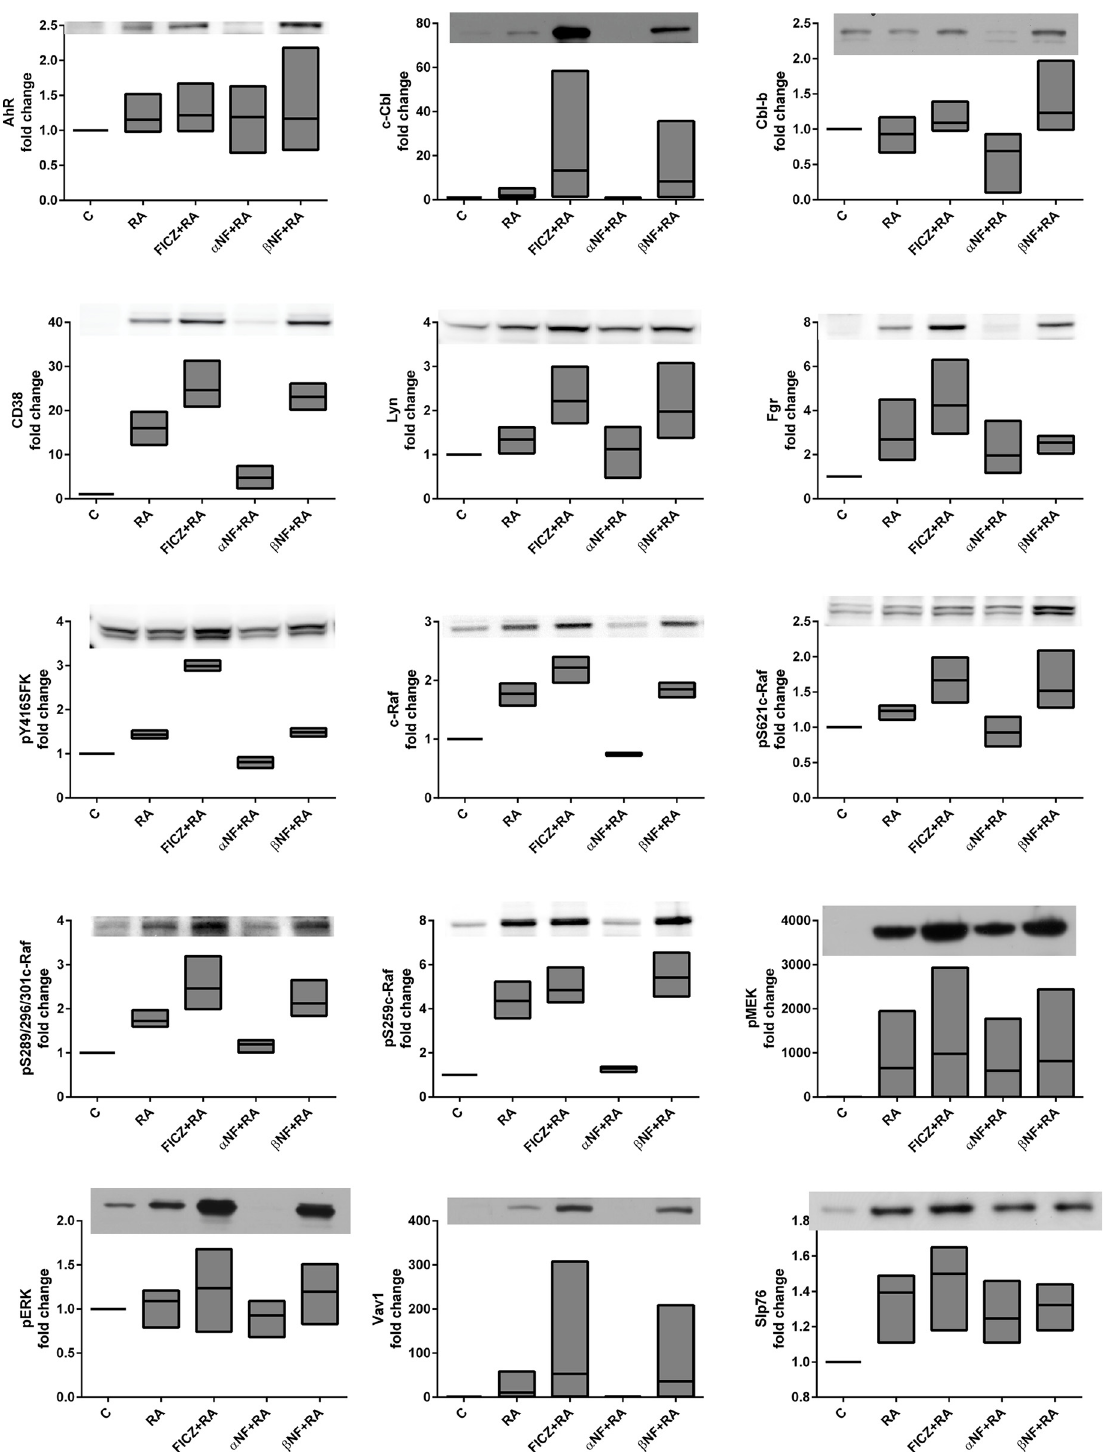
Fig 5. FICZ modulates RA-elicited signalsome. HL-60 cells were initiated in culture at 0.1 x 10 6 cells/ml with 1 μ M RA, 100 nM FICZ, 1 μ M α -NF and 1 μ M β -NF as indicated. Western blot assay of whole cell lysates is shown for AhR, c-Cbl, Cbl-b, CD38, Lyn, Fgr, pY416SFK, c-Raf, pS621c-Raf, pS289/296/301c- Raf, pS259c-Raf, pMEK, pERK, Vav1, Slp76. Whole cell lysates were collected after 48 h. Lysates were resolved on a 12% polyacrylamide gel. 25 μ g of protein was loaded in each well. Experiments were repeated at least three times. All the western blot data were quantified using ImageJ, normalized to GAPDH and then to untreated control and graphed as min to max floating bars with a line at the mean using GraphPad Prism software. P-value analysis cannot be performed on quantified blot data as this data is non-linear. A representative blot is shown for each marker.